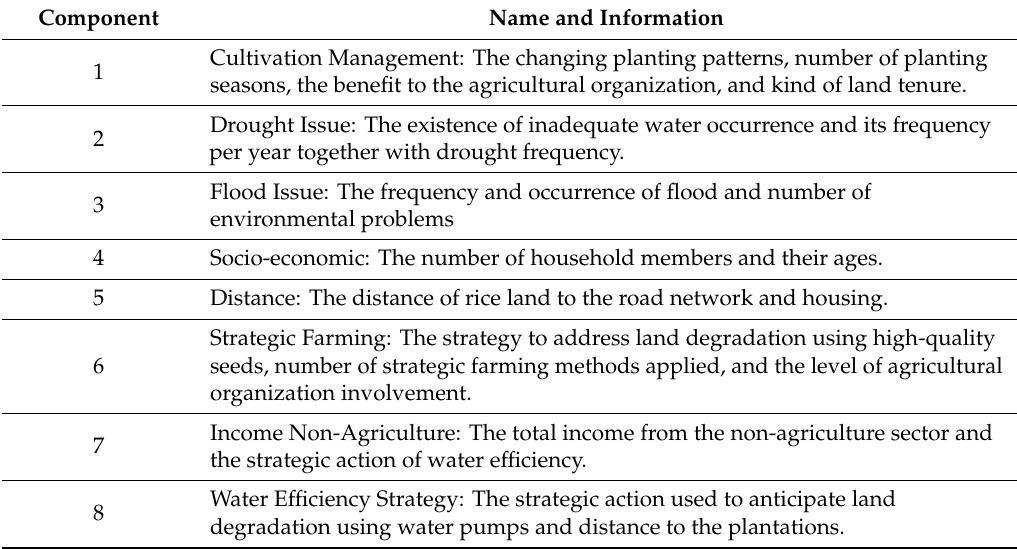
Table 12. The name and information of each